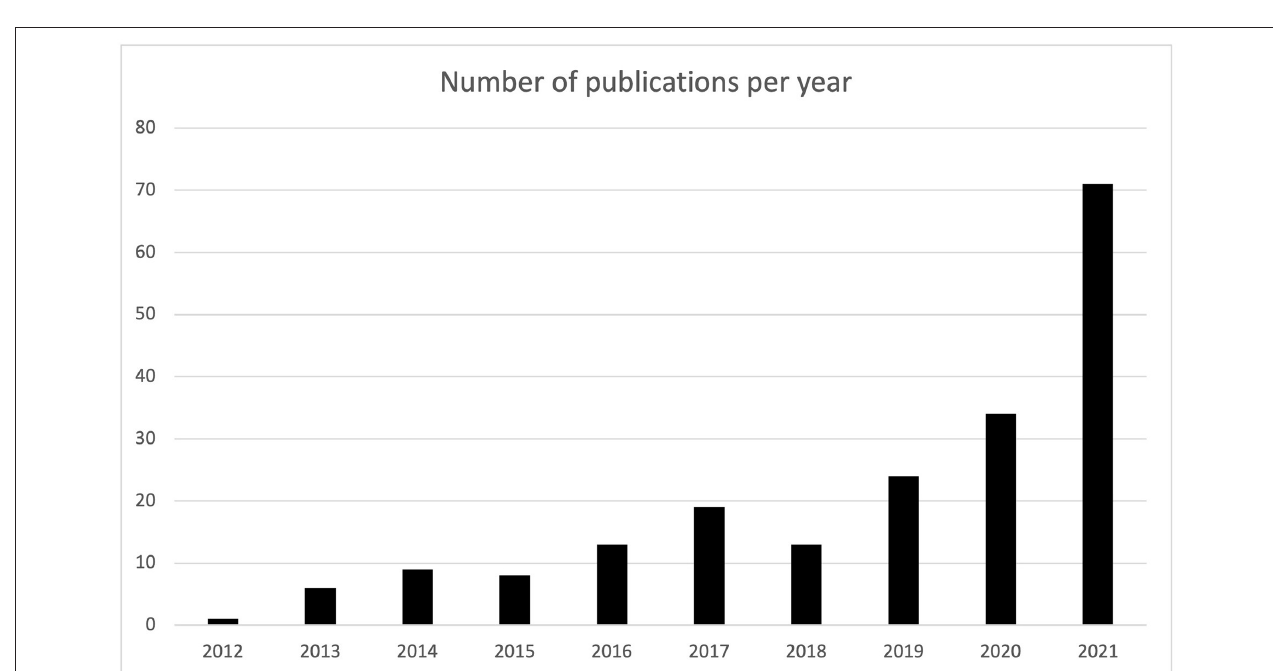
Frontiers in Surgery |